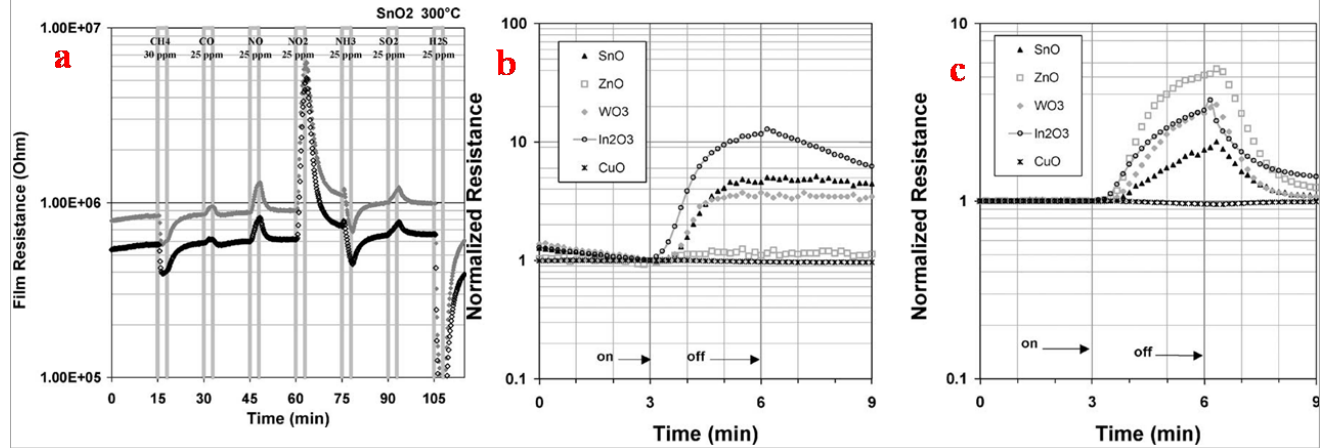
Figure 21. ( a ) Gas exposure sequence used at each temperature to determine the optimal operating temperature and ( b , c ) normalized response of SMO sensors to NO 2 at (a) − 200 °C and (b) − 400 °C. (Reprinted with permission from [1]. Copyright 2003, Elsevier). Table 1. Maximum sensitivities during the experiments on sensor operating temperatures. Here a negative value means that the sensor’s resistance decreased during the gas hit. If the resistance increased, the corresponding sensitivity is shown as a positive